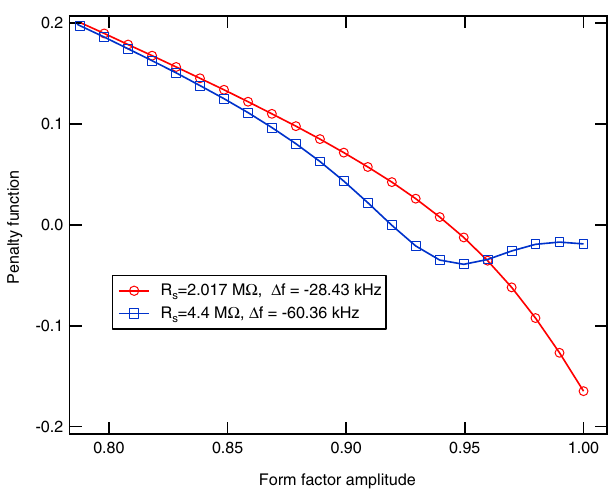
FIG. 11. Penalty as a function of the scalar form factor for low and high harmonic cavity shunt impedance cases.